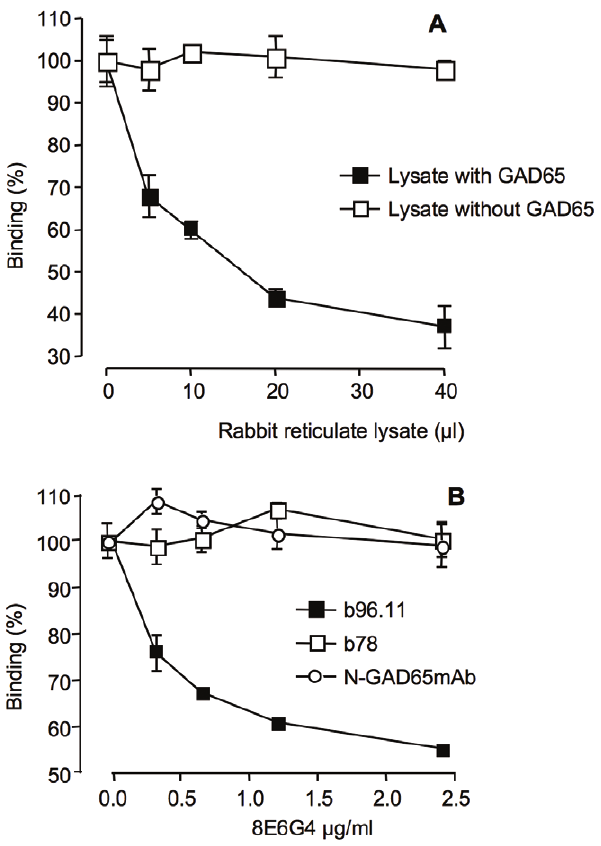
Figure 2. MAb 8E6G4 competes with b96.11 for binding to GAD65. A: GAD65 was translated in vitro using rabbit reticulocyte lysate. Different amounts (0–40 m l, corresponding to 0–160 ng) of recombinant GAD65 were incubated with 1.4 m g/ml MAb 8E6G4 and